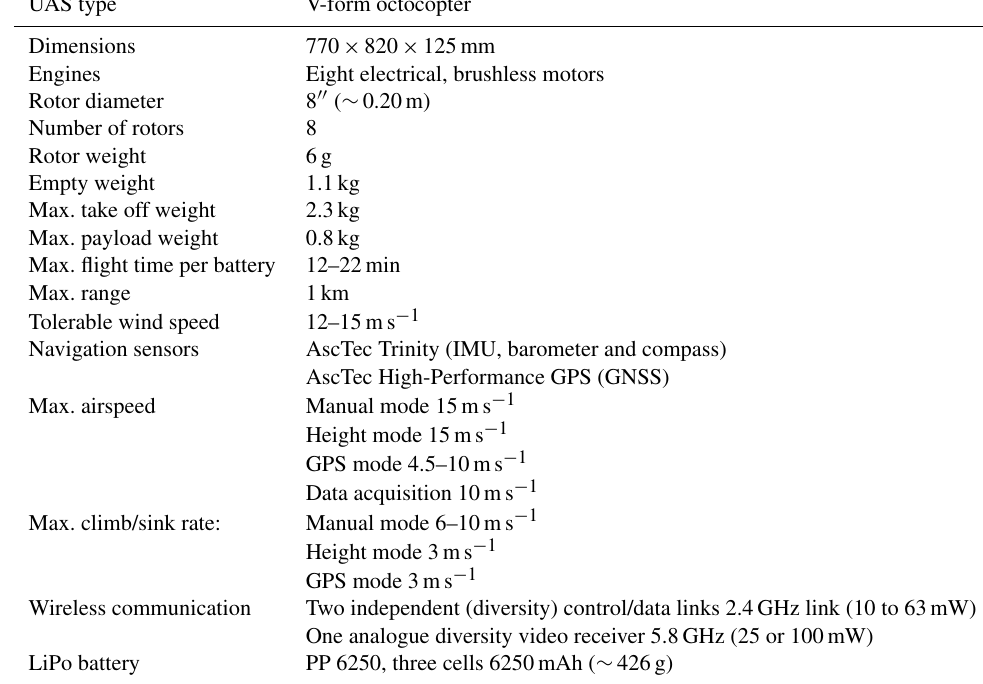
Table 1. Technical specifications of the Falcon 8